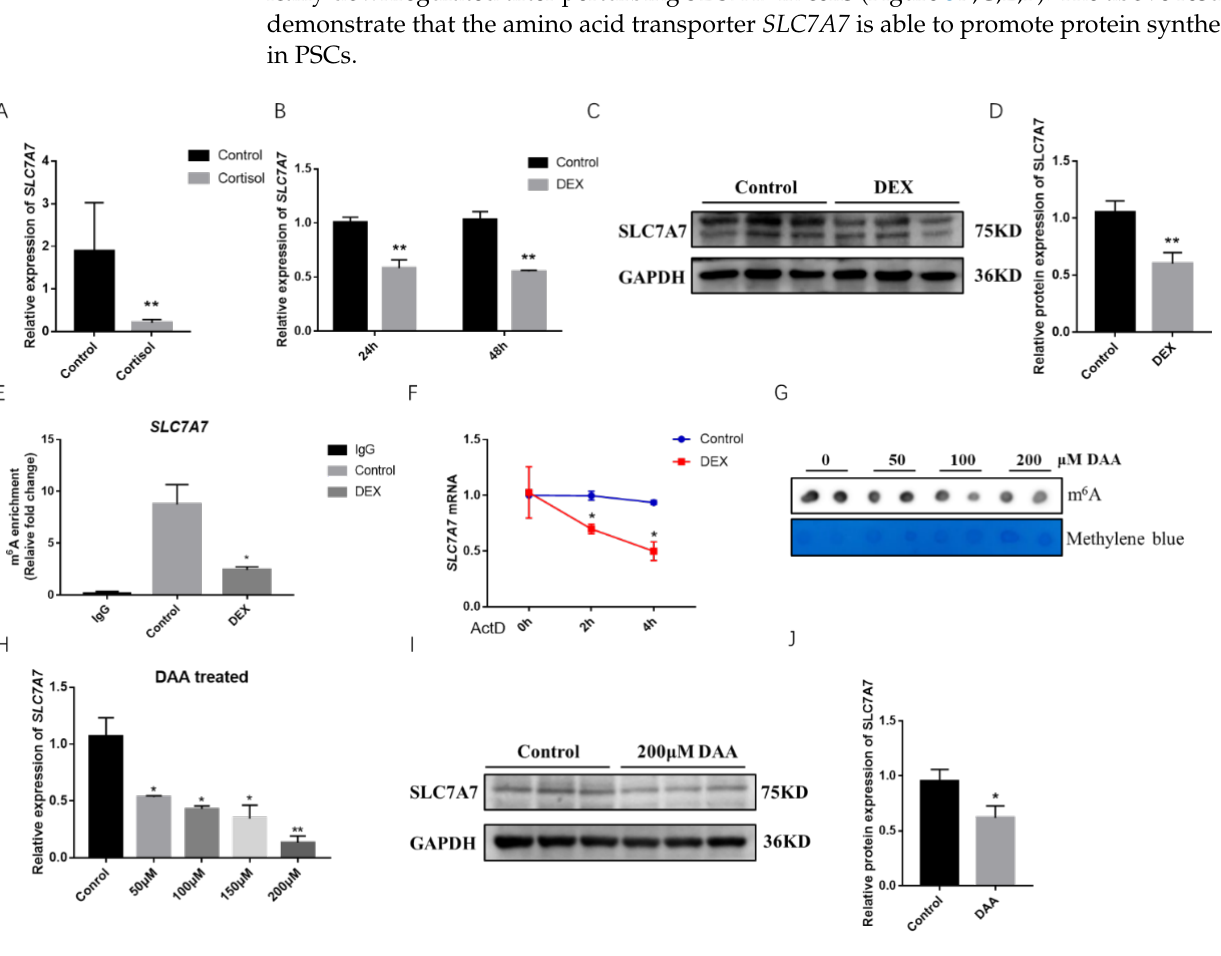
Figure 3. Effect of GCs on the amino acid transporter SLC7A7 . ( A ) The mRNA expression levels of SLC7A7 in longissimus dorsi muscle of the cortisol group and the control group, respectively; ( B ) the mRNA expression levels of SLC7A7 after DEX treatment for 24 h and 48 h; ( C ) the protein expression levels of SLC7A7 after DEX treatment; ( D ): quantification of Western blotting under the treatment of DEX; ( E ) validation of m 6 A modification in SLC7A7 mRNA by MeRIP-QPCR; ( F ) the mRNA expression of SLC7A7 was detected at 0, 2 and 4 h after ActD treatment; ( G ) Dot blot detection of m 6 A modification levels after treatment with 0, 50, 100 and 200 µ M DAA; ( H ) the mRNA expression level of SLC7A7 after treatment with 0, 50, 100 and 200 µ M DAA; ( I ) the protein expression levels of SLC7A7 after treatment with 200 µ M DAA; ( J ) quantification of Western blotting under the treatment of DAA. *, ** indicate significant difference at p < 0.05 and p < 0.01, respectively.